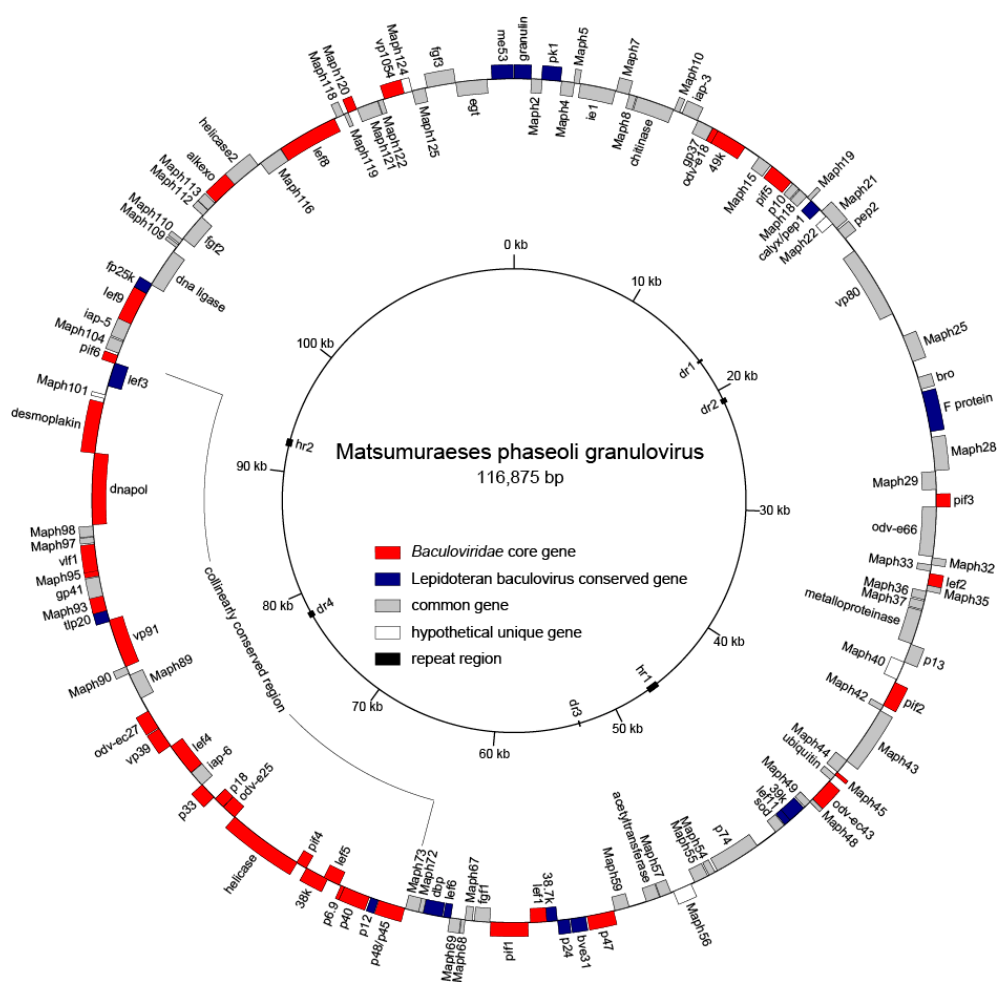
Figure 2. Whole-genome map for MaphGV. Genes in the positive strand are drawn to the outside of the circle and those in the negative strand are on the inside. The gene types are coded as follows: red for core genes, blue for lepidopteran conserved genes, white for hypothetical unique genes, and grey for other common baculovirus genes. Black squares in the inner circle represent repeat regions. The arc indicates the collinearly conserved region. Table 1. Gene contents of MaphGV.